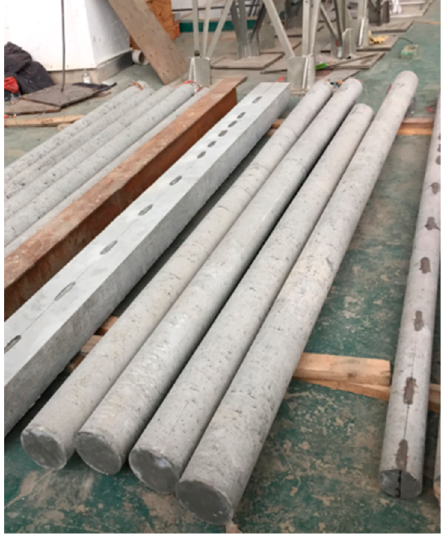
Figure 1. Specimens for testing. Table 2. Design parameters of all specimens.